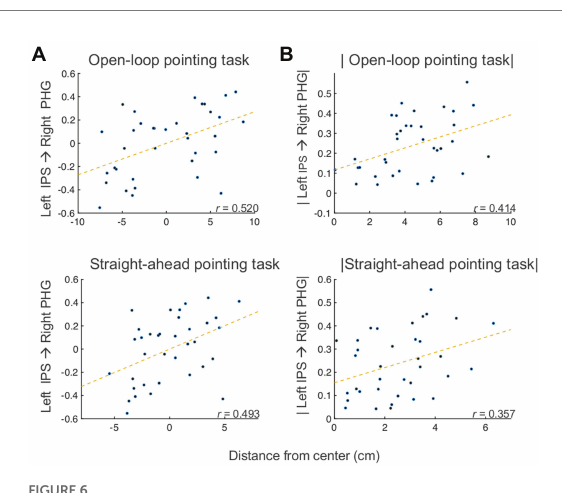
FIGURE 6 Bain-behavior correlation. (A) Partial correlations between post minus pre PA changes in left IPS → right PHG connection and open-loop pointing (top) and straight-ahead pointing (bottom) tasks. (B) Partial correlations between post minus pre PA changes (absolute values) in left IPS → right PHG connection and open- loop pointing (top) and straight-ahead pointing (bottom) tasks. IPS, intraparietal sulcus; PHG, parahippocampal